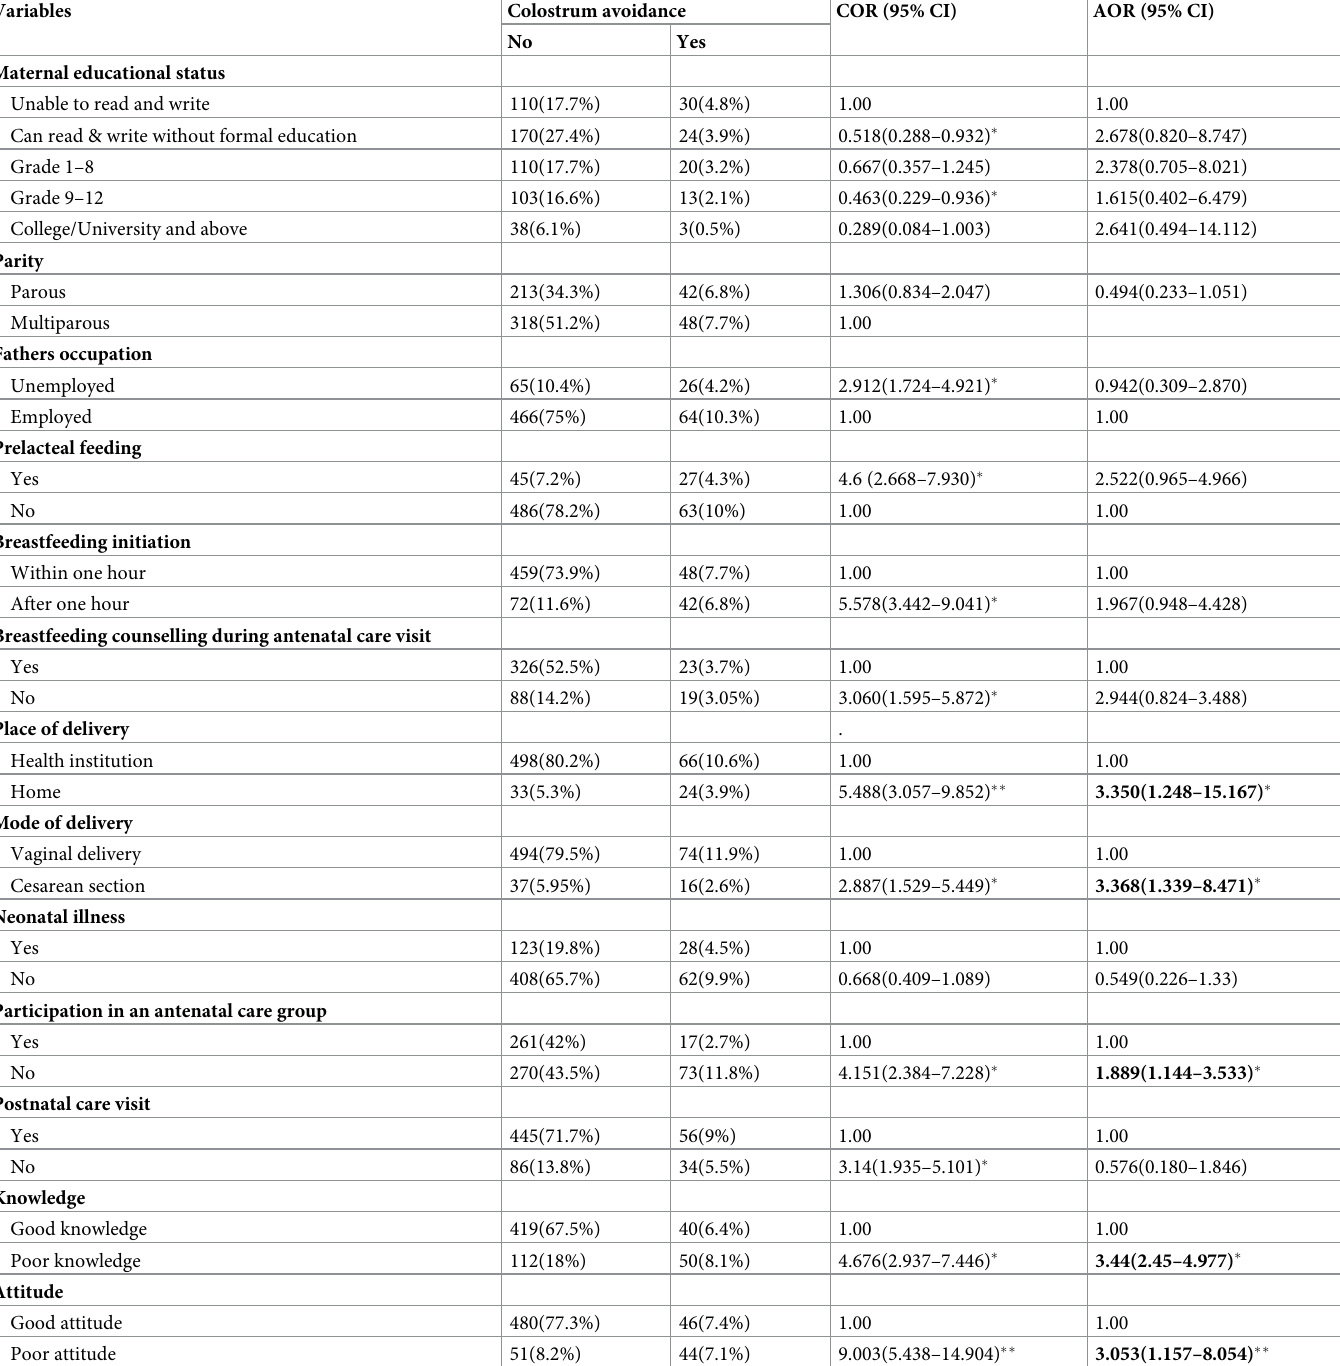
Table 3. Bivariate and multivariate logistic regression analysis of colostrum avoidance and its explanatory variables in Bure District, Amhara Region, North West, Ethiopia,2019(n =